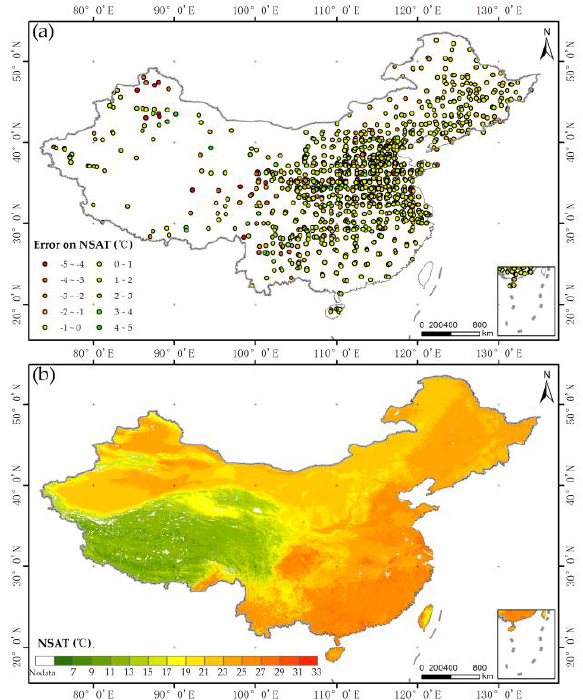
Figure 2 ( a ) The regression residual derived from GWR model in June 2010, ( b ) NSAT map derived using the GWR model in June 2010. Figure 3 represents the RMSE and R 2 of the predicted monthly minimum, mean, and maximum NSAT using the GWR model in China in 12 months of 2010. In the colder months (i.e., from January to March and from October to December), the RMESs of the predicted monthly mean NSAT using the GWR model are lower than those of the monthly maximum NSAT, and the RMSEs of the predicted monthly maximum NSAT are lower than those of the predicted monthly minimum NSAT. In the warmer months (i.e., from April to September), the RMSEs of the predicted monthly mean and minimum NSAT are similar, and both of them are lower than those of the predicted monthly maximum NSAT. The mean RMSEs for 12 months using the GWR model are 1.52 °C for monthly mean NSAT, 1.62 °C for monthly minimum NSAT, and 1.62 °C for monthly maximum NSAT, respectively. The Total RMSE for three NSAT variables is 1.58 °C. The R 2 for monthly minimum, mean, and maximum NSAT are similar in the colder months. The R 2 decrease in the order from monthly minimum, to mean, to maximum NSAT in the warmer months.